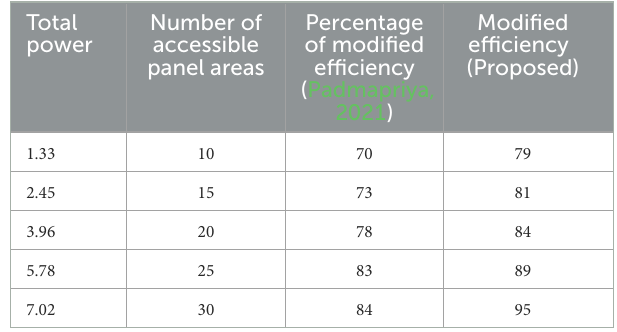
TABLE 5 Effectiveness with power